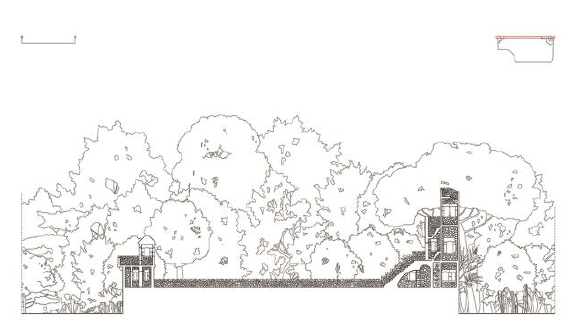
Figure 4 . The Quinta da Regaleira in Sintra, the Terraço dos Mundos Celestes , cross section.